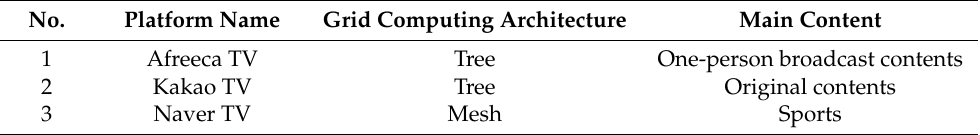
Table 2. Live-streaming platforms in Korea using grid computing technology.